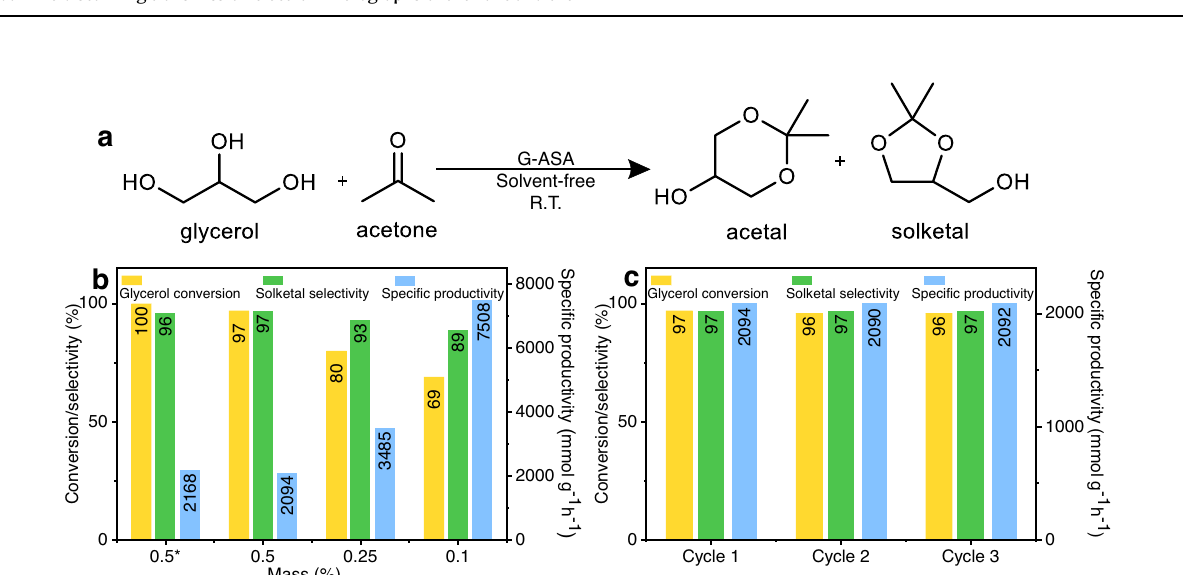
Fig. 2 | Structural identity of G-ASA catalyst. a – c High-resolution transmission electron micrographs of few-layered fl akes of the G-ASA catalyst. d High-angle annulardark- fi eldscanning transmission electron micrographs of the fl akeand the